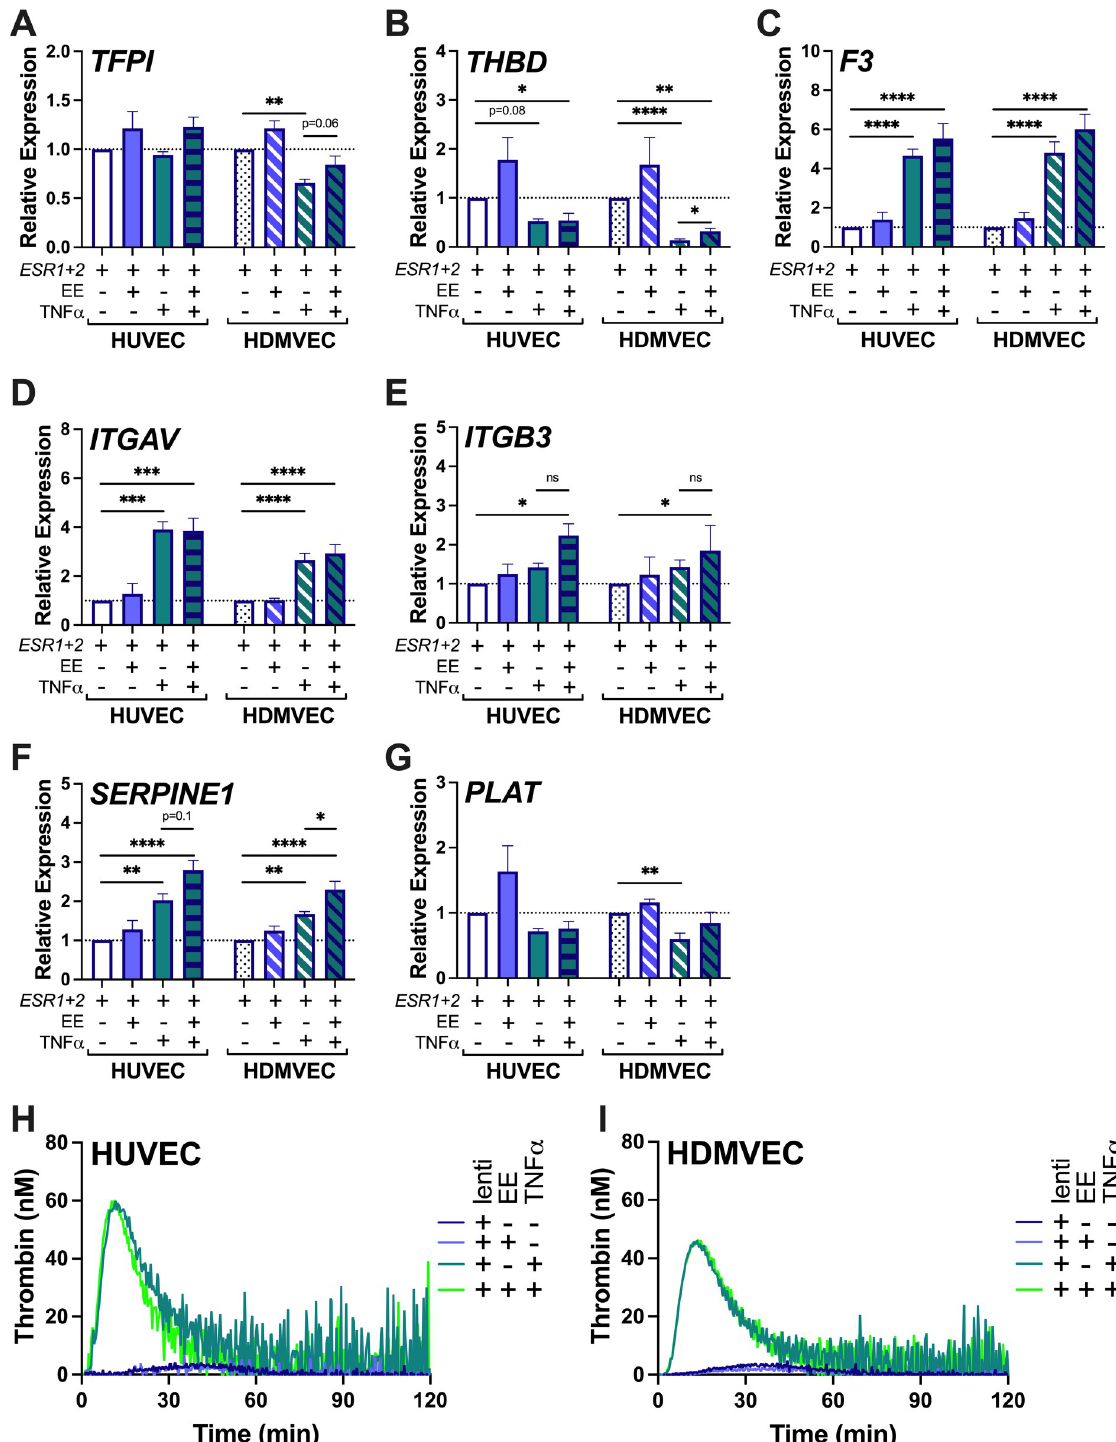
Fig 6. Combined inflammation and overexpression of ESR1 and ESR2 in HUVEC and HDMVEC does not facilitate a prothrombotic response to EE. Transcript expression of (A) TFPI , (B) THBD , (C) F3 , (D) ITGAV , (E) ITGB3 , (F) SERPINE1 , and (G) PLAT was measured by RT-qPCR following 72 hours lentiviral transduction and 24 hours of subsequent 1 nM EE and/or 10 ng/mL TNF ɑ treatment (N = 4; Bars = mean + SEM; * p < 0.05, ** p < 0.01, *** p < 0.001, **** p < 0.0001). The lenti-ESR1+2, and lenti-ESR1+2 +EE data are reproduced from Fig 5 for comparison. Thrombin generation in NPP stimulated by (H) HUVEC or (I) HDMVEC treated with lentiviral vector and EE (single curves representative of N = 4 experiments in duplicate). Thrombin generation parameters and statistical analyses are provided in S2 File. https://doi.org/10.1371/journal.pone.0284333.g006 PLOS ONE | https://doi.org/10.1371/journal.pone.0284333 April 19,